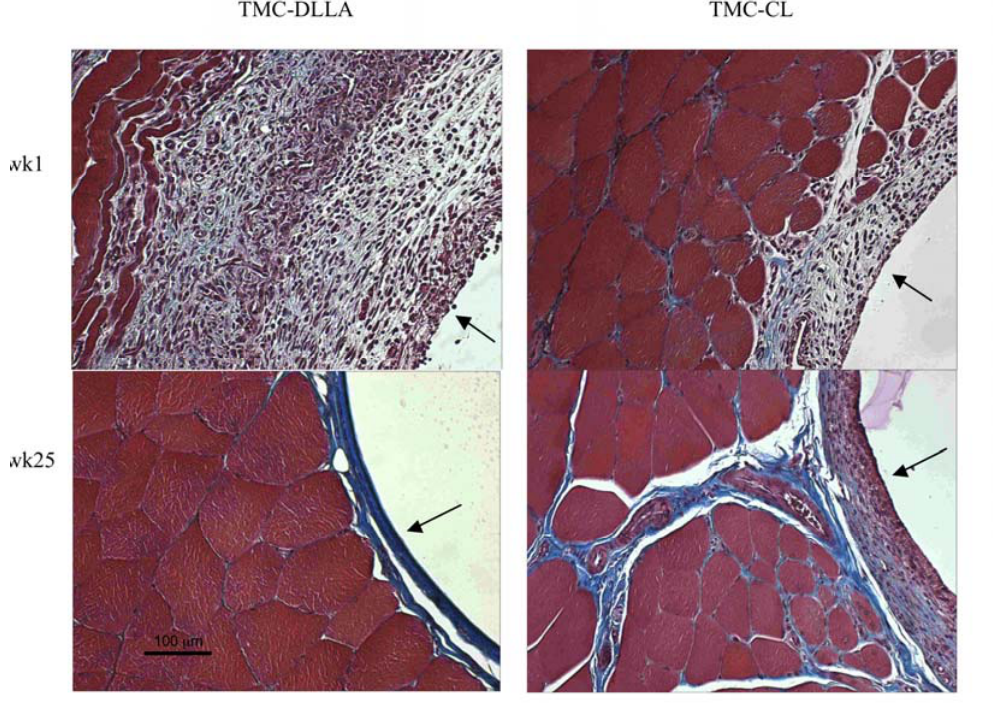
Figure 6. Representative Masson trichrome-stained sections of the tissue surrounding the cylinder implants at week 1 (wk1) and week 25 (wk25). In this staining procedure, collagen stains blue, cytoplasm stains pink/red, muscle stains red, and nuclei stain black. The polymer-tissue interface is indicated by the black arrows.